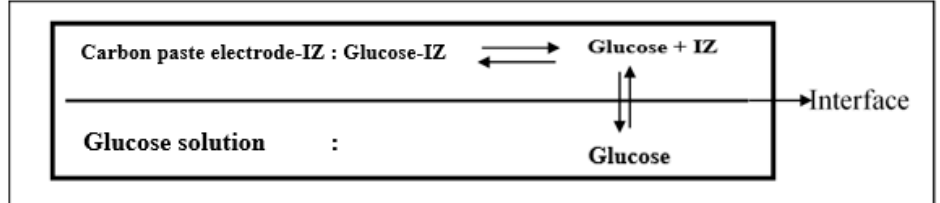
Figure 9. Mechanism of glucose equilibrium, which results in potential difference on the electrode surface in potentiometry. surface in potentiometry.